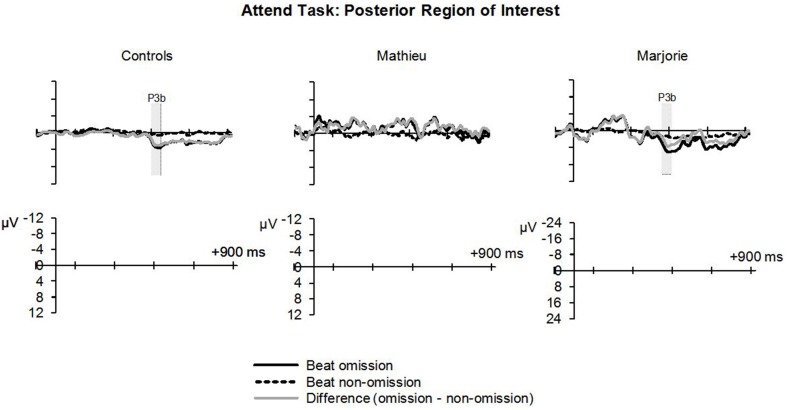
Attend task: P3b. Grand averaged ERPs elicited by deviant beat omissions and corresponding standard target beats in the attend task at the posterior region of interest for the control participants (left column), Mathieu (middle column), and Marjorie (right column). Shaded regions depict P3b mean amplitude analysis time window. Negative is plotted upward. Mathieu's P3b time window is not shown because his mean P3b amplitude could not be distinguished from estimations of noise-based voltage levels.